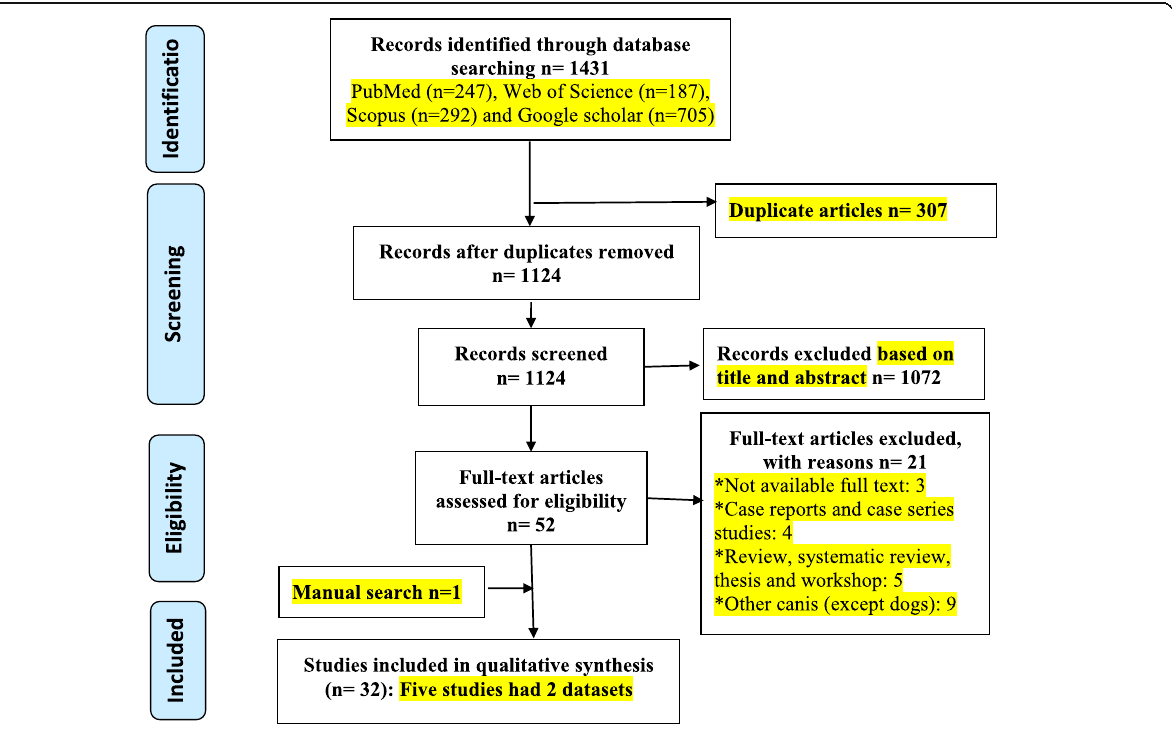
Fig. 1 PRISMA flow diagram describing included/excluded